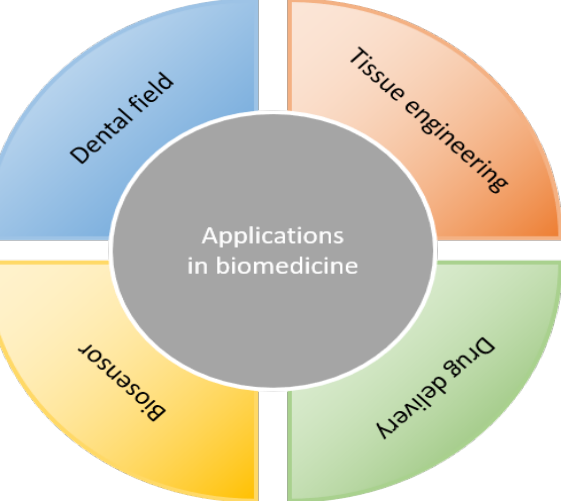
Figure 5. Applications of the combination of SF and graphene-based materials in biomedicine.